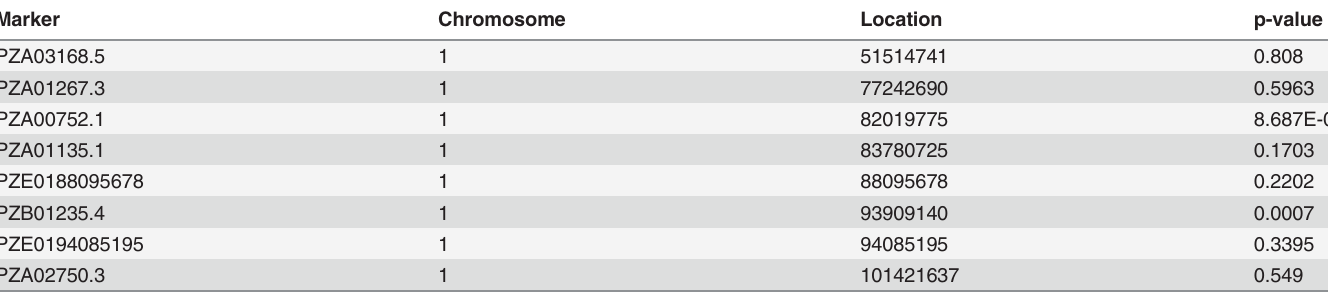
Table 4. Markers and associated p-values from the qGLS1.04 fi ne-mapping analysis.